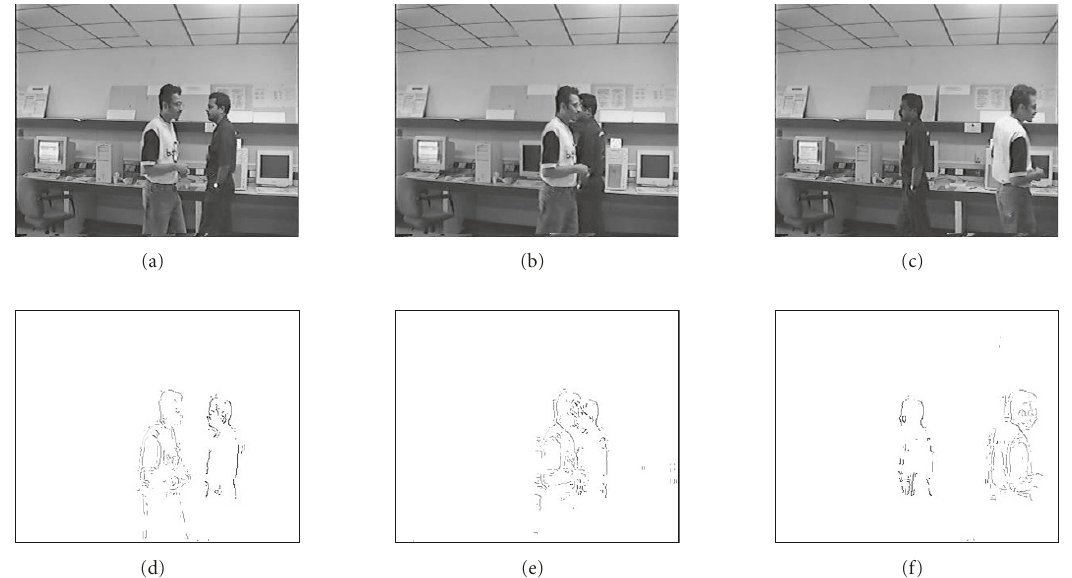
Figure 5: Two men walk sequence (a) image frame at time t = 6 (b) image frame at time t = 12 (c) image frame at time t = 35. Motion points in di ff erent gray values based on direction detected (d) at time t = 6 (e) when the men are crossing, at time t = 12, and (f) after the men crossed, at time t = 35.